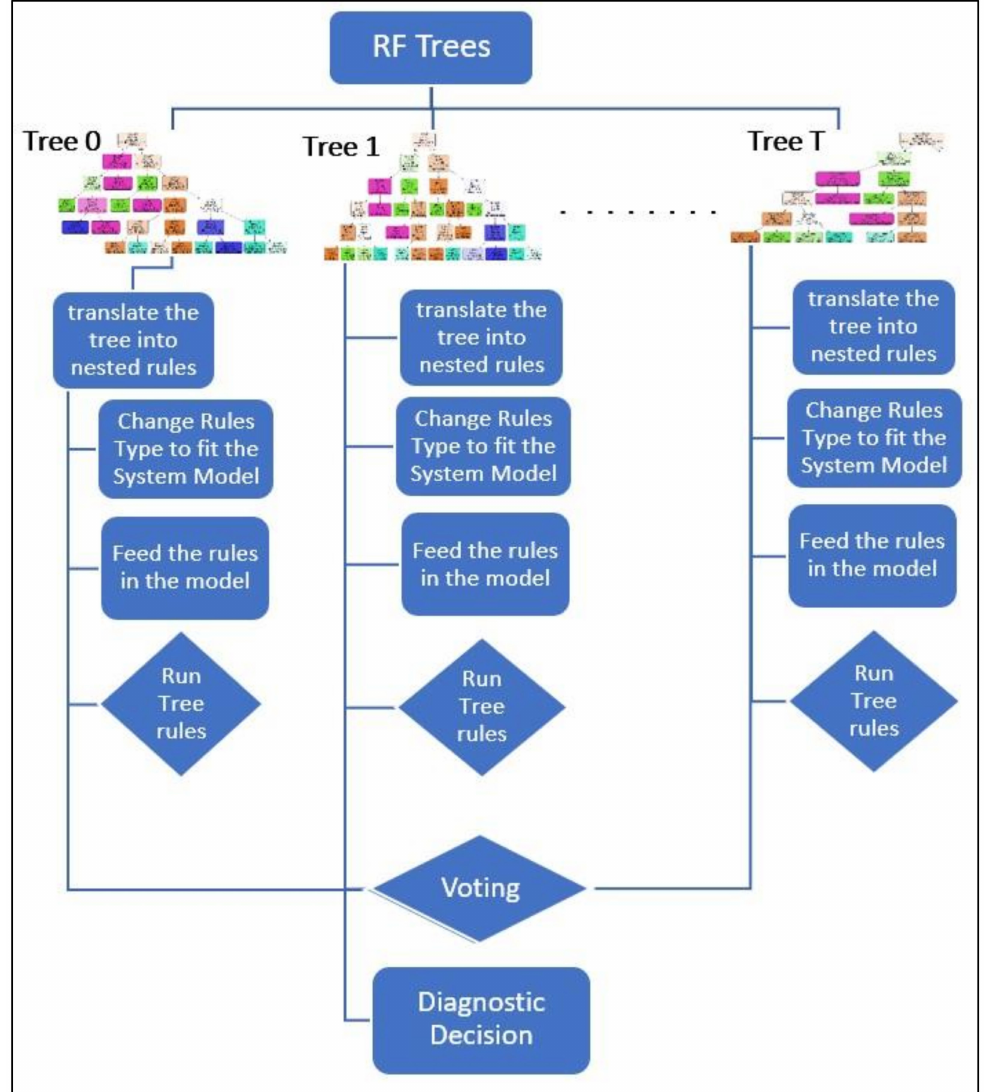
Figure 5. A Hybrid RF Approach Between Data-driven and Model-based